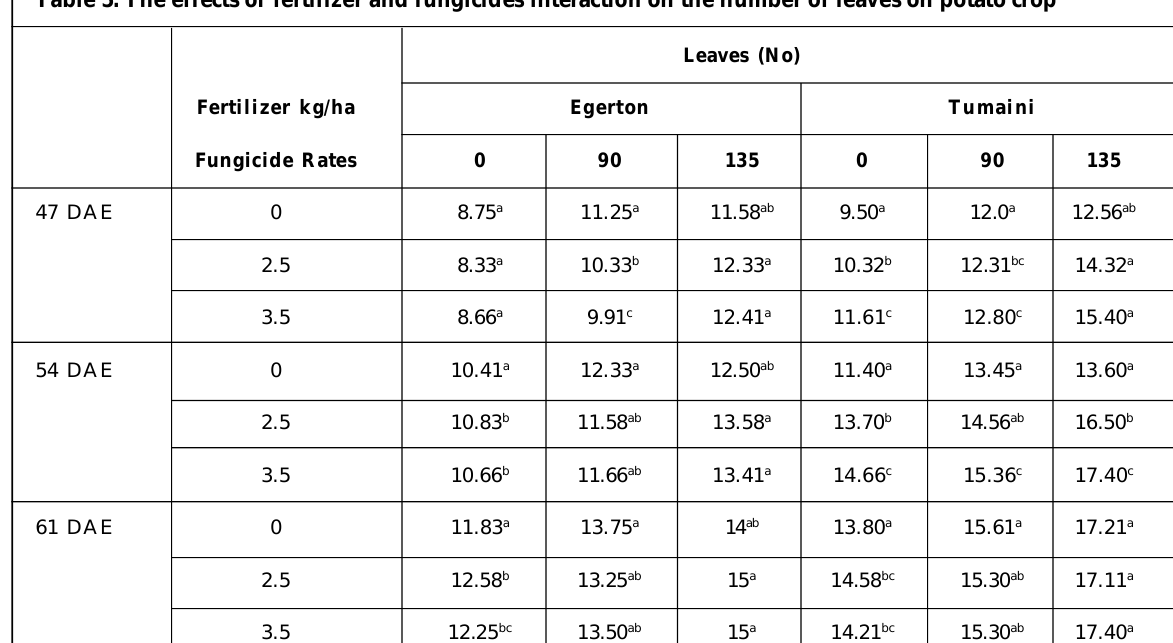
Table 6: Effects of fertilizer and fungicide interactions on the potato yield Fertilizer (kg/ha) / 0